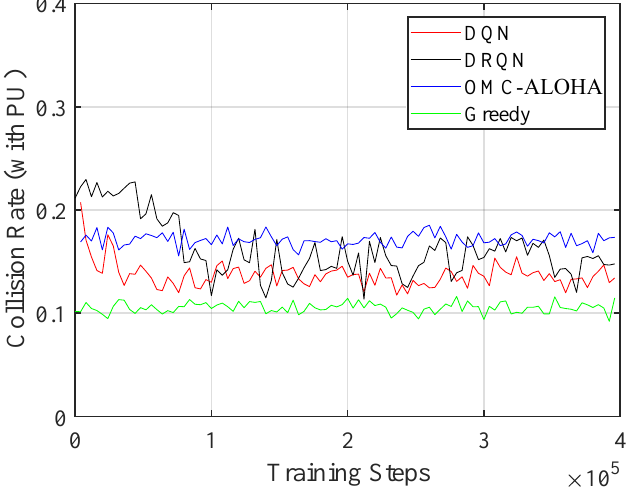
Figure 7. The collision rate of the proposed method with different training steps (multiple SUs).